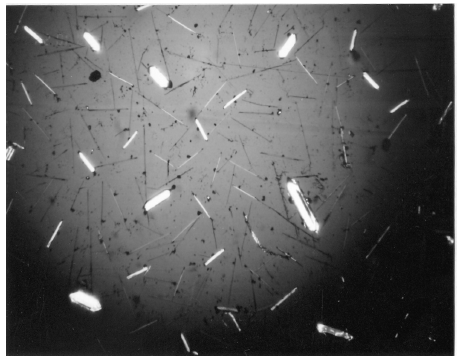
Figure 1. Cysteic acid crystals (needle shaped